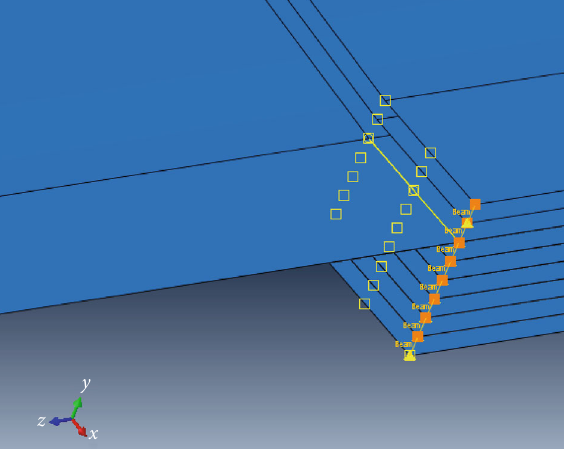
Figure 7: Constraint simulation of 3 M